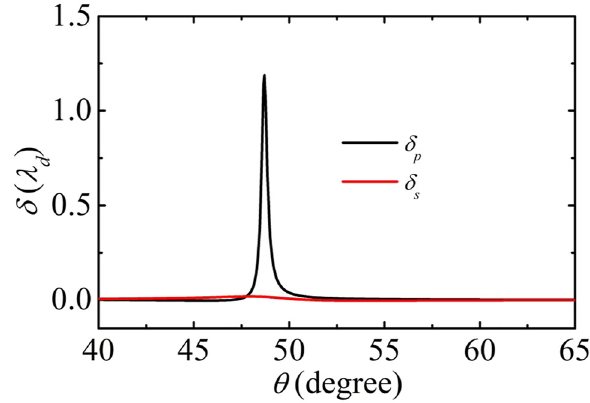
Figure 7: The transverse shifts 𝛿 of the linearly polarized reflected components by linearly polarized incident beams. The parameters are the same as Figure 6.